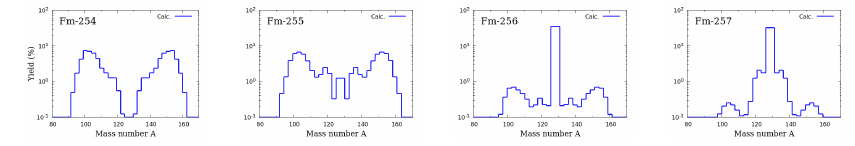
Figure 1. Calculation results of a fission fragment mass distribution for 254 − 257 Fm (E ∗ = 7